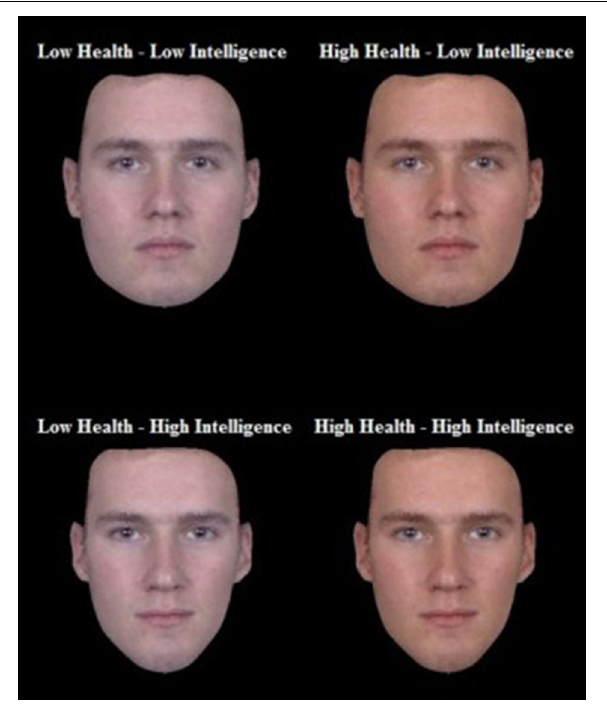
FIGURE 1 | Example of the four face types created by independently manipulated high and low signals of health and